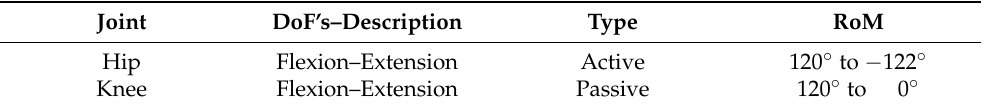
Table 1. The hip and knee joints with their range of motions (RoMs)